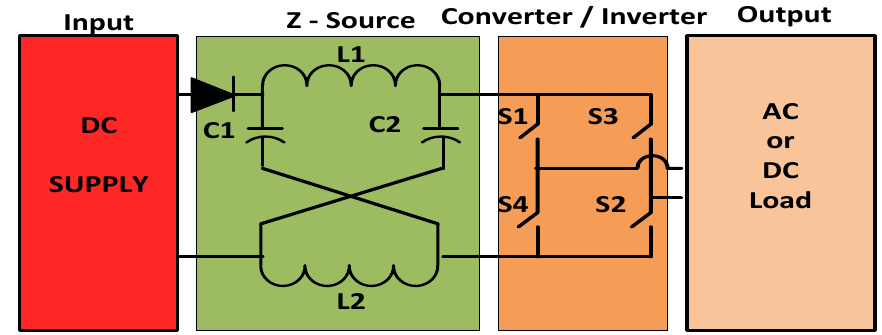
Figure 2. Simplified circuit arrangement of Z-Source DAD converter. (L1, L2 split inductors, C1, C2 split capacitors, S1–S4 switches).